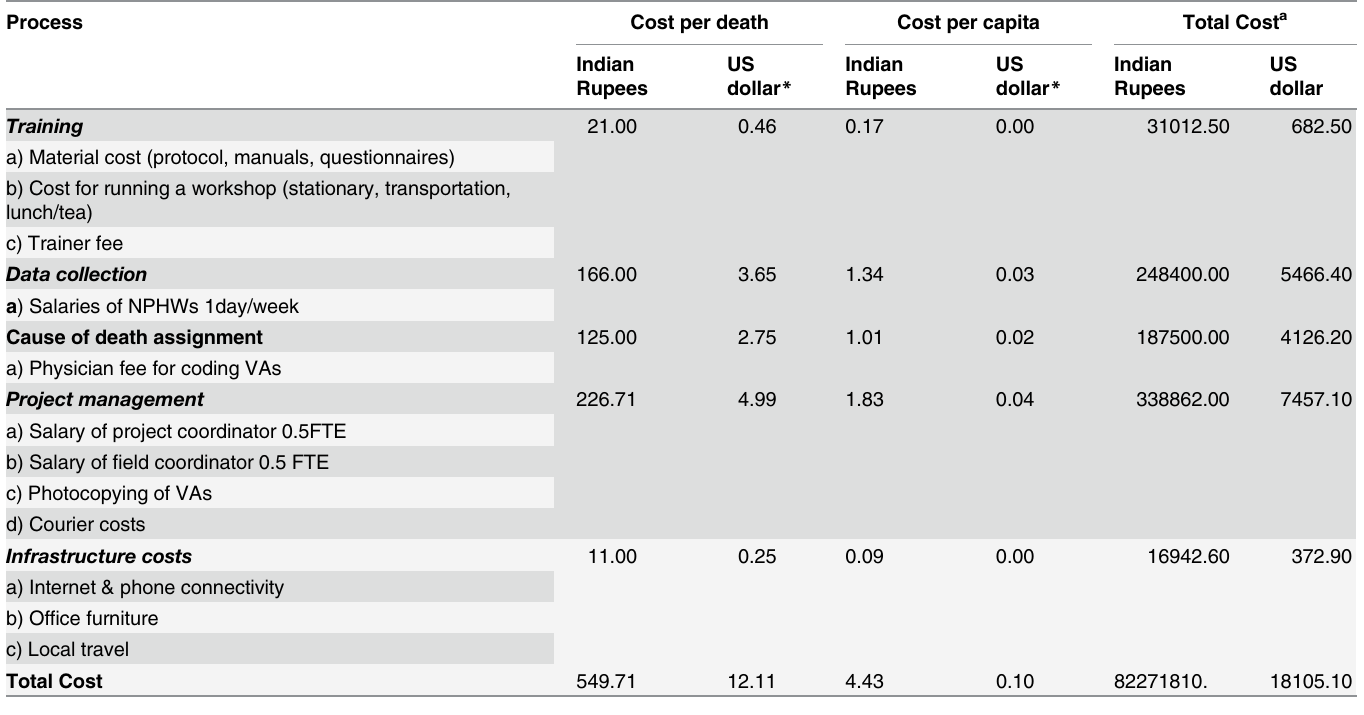
Table 2. Cost for running the surveillance for subsequent years (2004 –